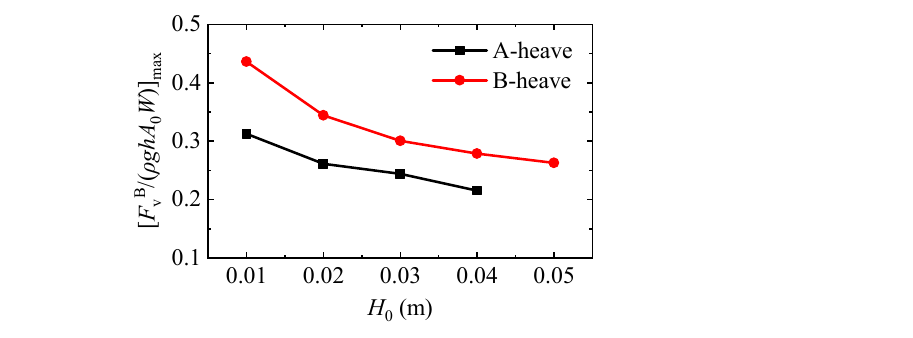
0 W )] max for the B-Heave system are consistently higher than those for the A-